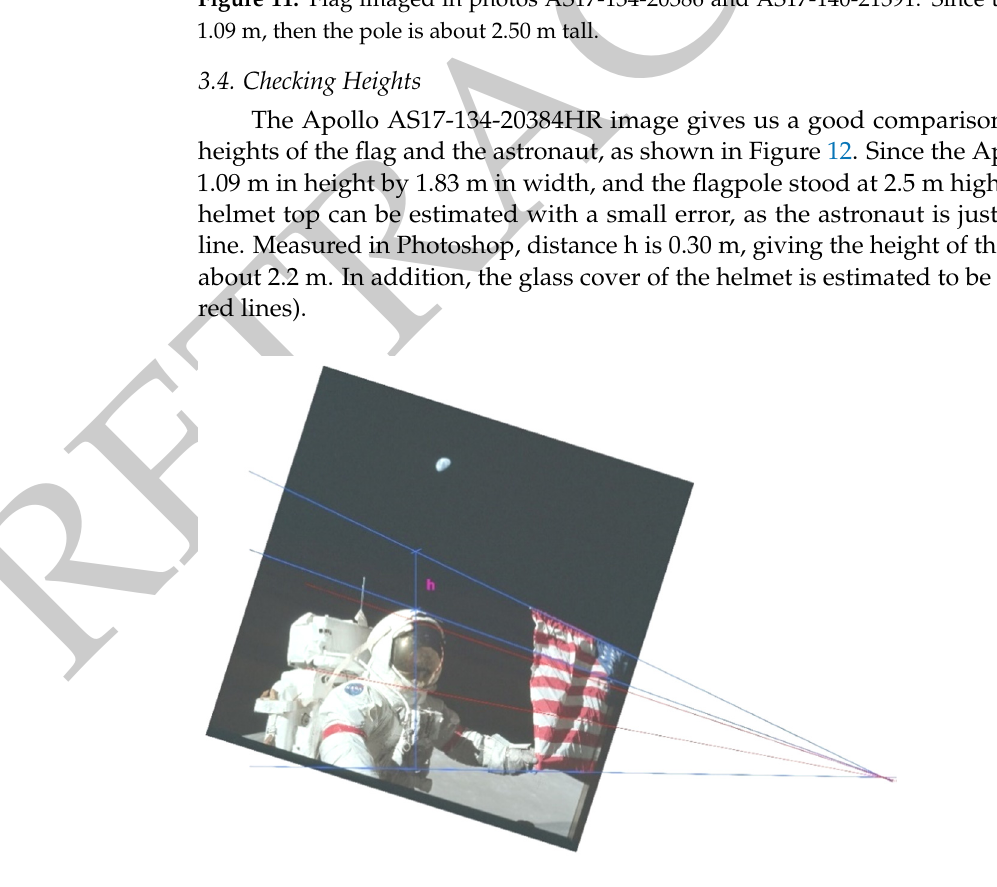
Figure 12. Apollo Nasa Library AS17-134-20384HR image used for the estimation of the astronaut height.